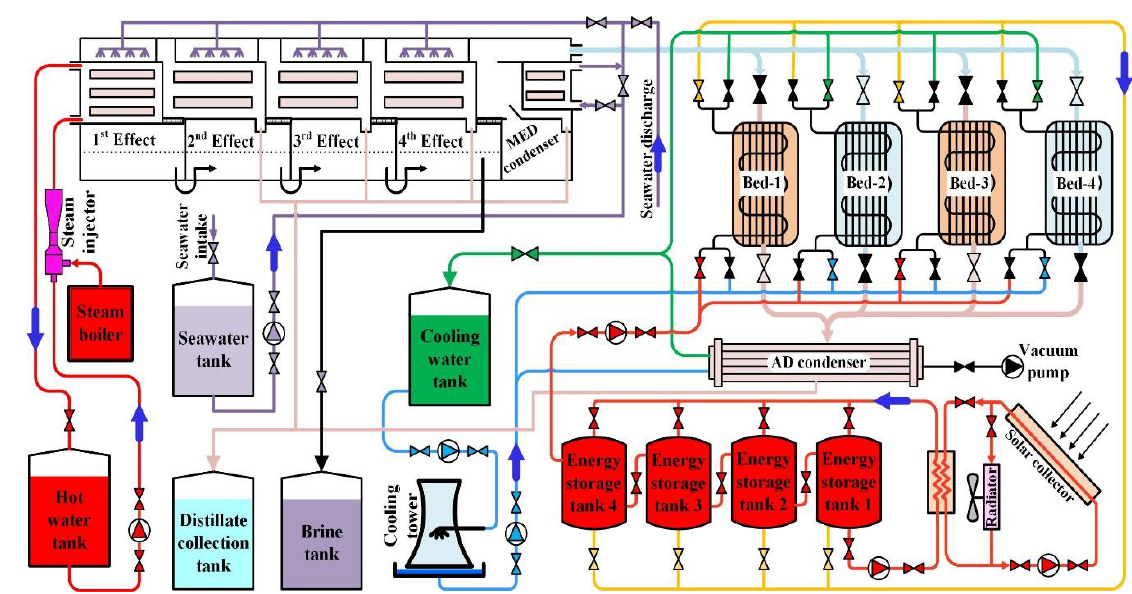
Figure 14. Schematic of a hybrid MED-AD system (adapted from [119]).